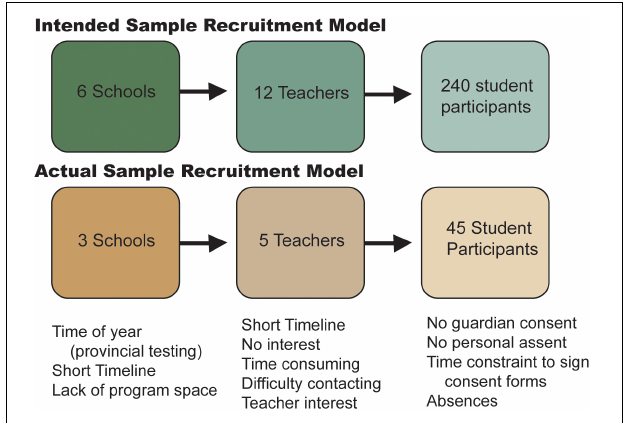
FIGURE 9 | Sample attrition model. Model demonstrating the loss of potential participants at each step of the recruitment process. The top diagram models the optimum flow of recruitment, ending with 240 student participants, while the bottom demonstrates the actual flow of recruitment along with reasons for potential participant attrition below each